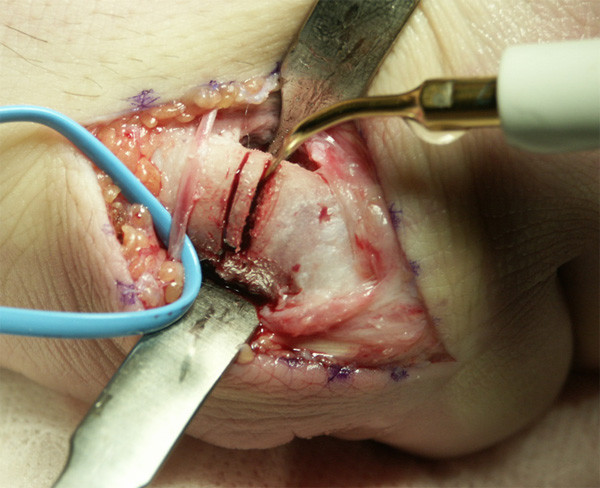
Closing wedge osteotomy using the Piezosurgery Device®.